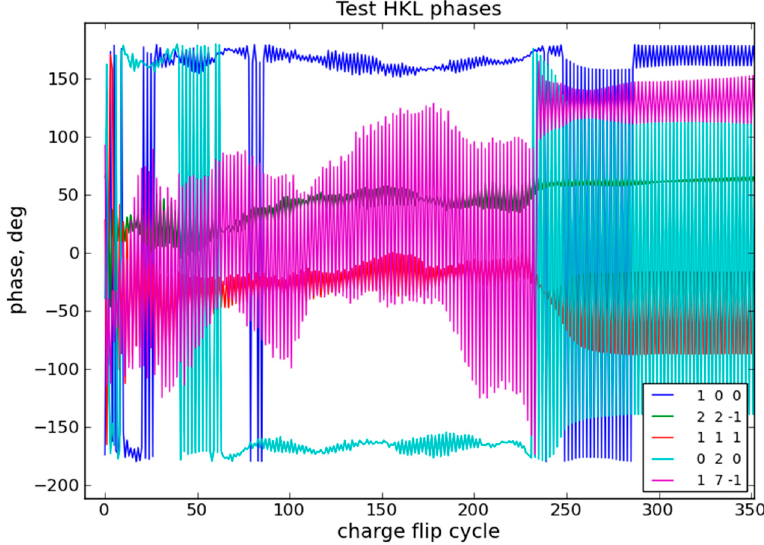
Figure 8. Detail of the initial CF cycles for sucrose showing phases of five reflections before and after the convergence (cycle ~240).